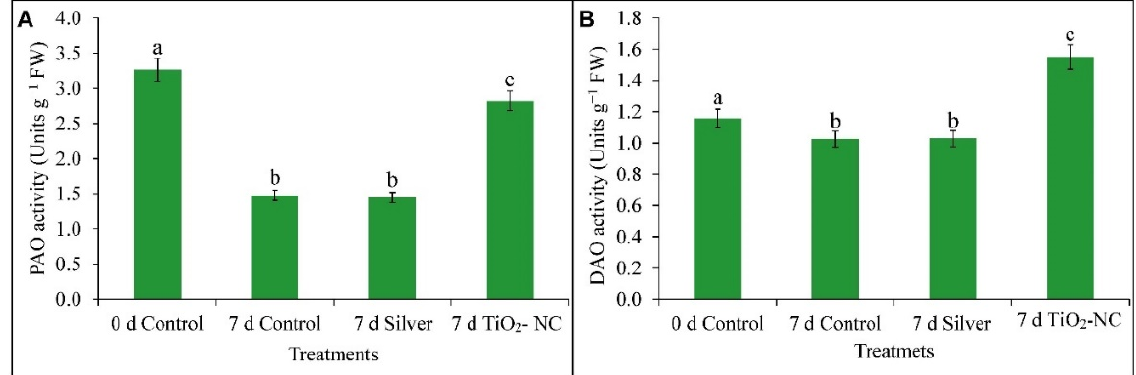
Figure 8. Activity of PAO ( A ), DAO ( B ) from pulp tissues of Capsicum on tissues under silver and TiO 2 -NC treatments with respect to control (0 d) and 7 d storage of postharvest at 25 °C. Vertical bars showing SE ± 1 ( n = 3) on each column and letters (a, b, c and d) above bars indicate statistical variations between treatments based on one way ANOVA ( p ≤ 0.05).